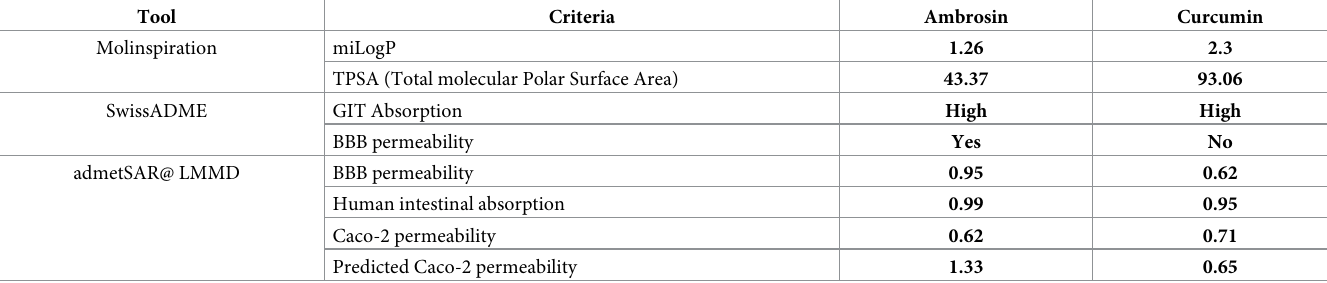
Table 1. Comparison of in silico predictions of pharmacokinetic properties of ambrosin and curcumin using different tools.